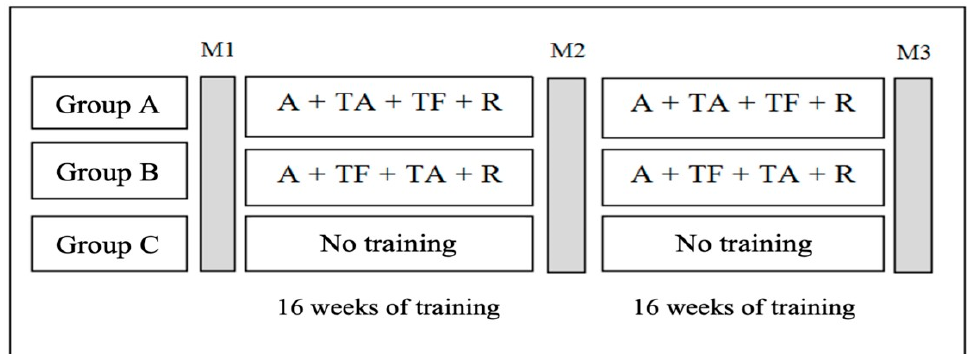
Figure 1. Illustrative study outline. Abbreviations: A—Warm-up; M1—first moment of evaluation, basal level; M2—second moment of evaluation; M3—third moment of evaluation, at the end of study; R—stretching and cool down; TA—Aerobic training; TF—strength training.